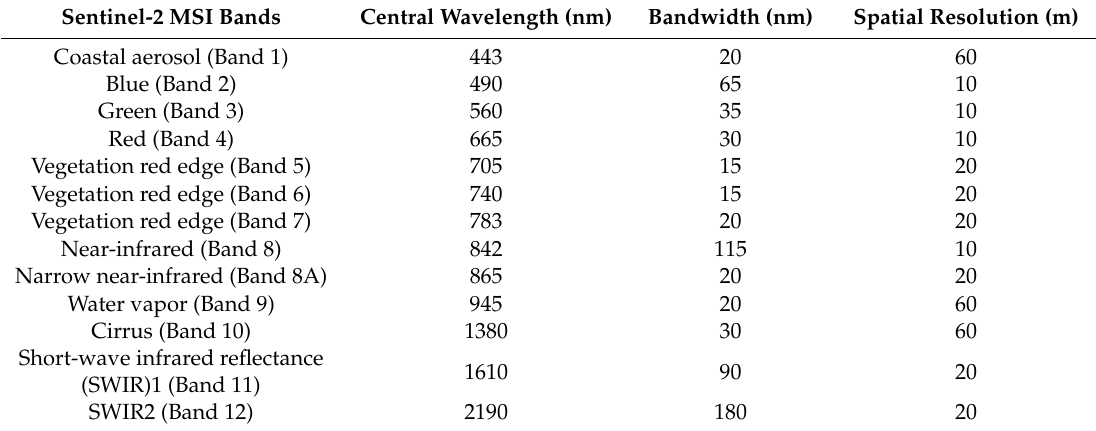
Table 1. General characteristics of Spectral bands for the Sentinel-2 MultiSpectral Instrument (MSI)